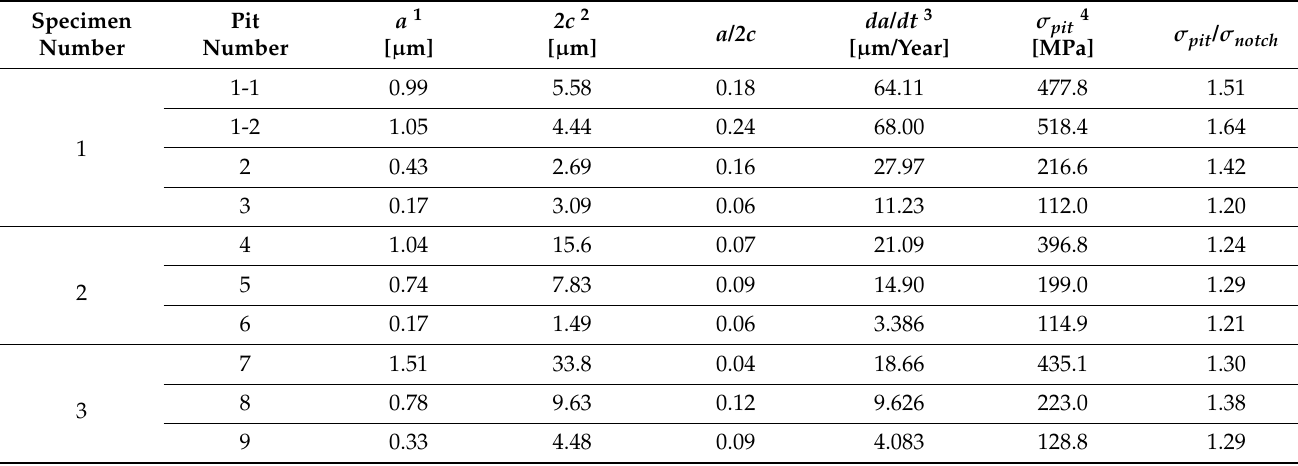
Table 3. Pit dimensions (depth a and width 2c ) and pit growth rates (calculated as da/dt ). Note that values of σ notch are given in Table 2.